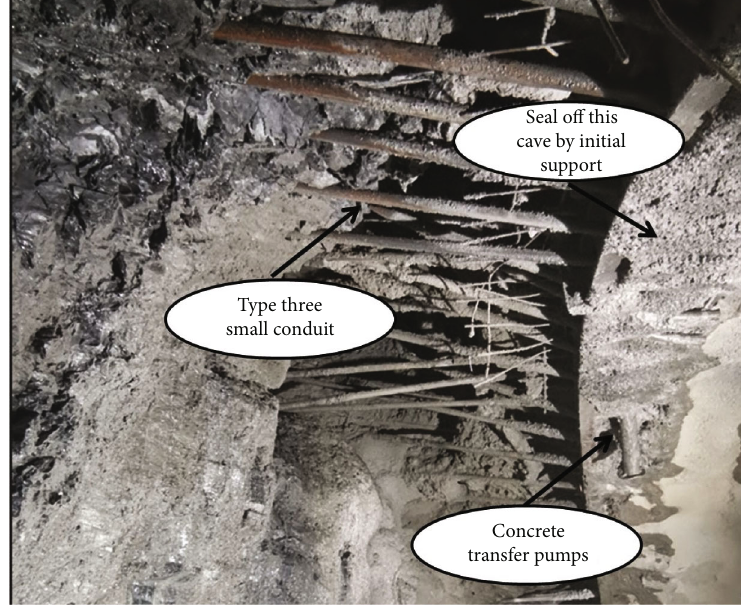
Figure 10: Treatment measures for the